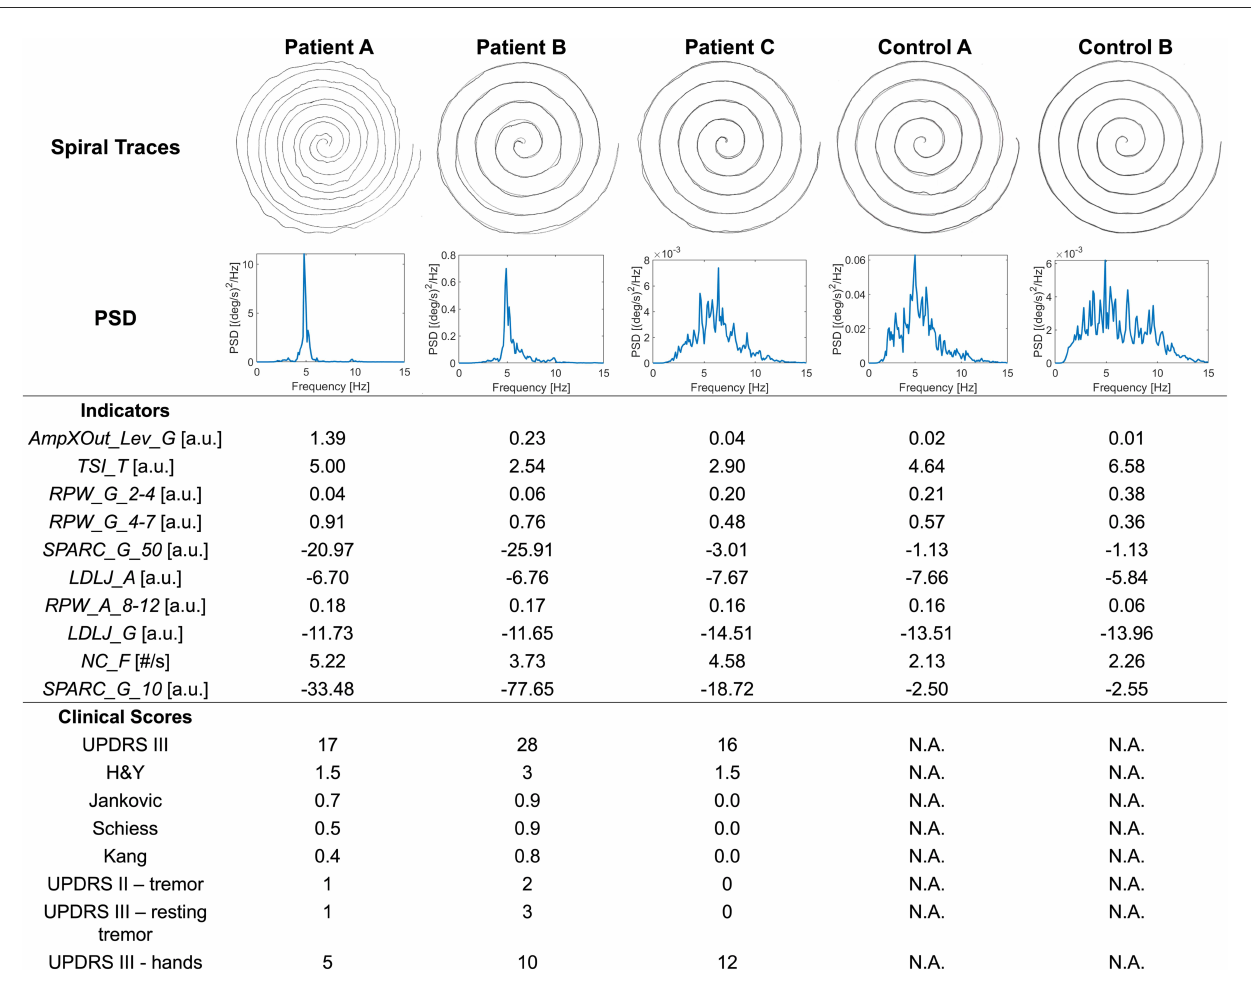
FIGURE1 Spiral traces, angular velocity PSD, relevant indicators, and clinical scores for three patients (A–C) and two control subjects (A,